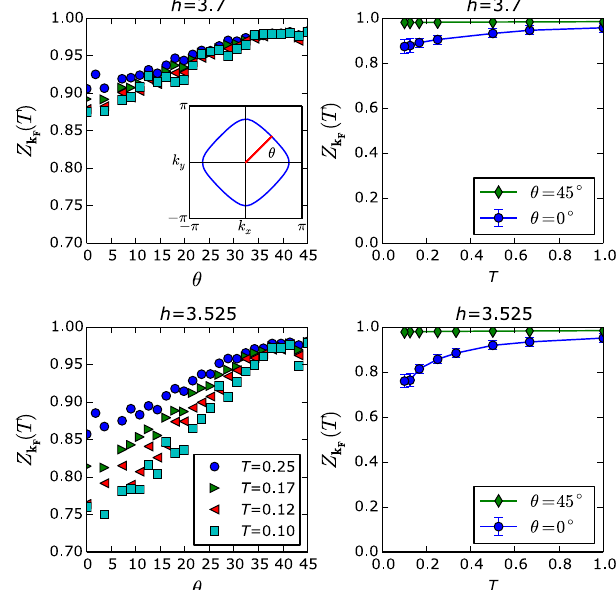
FIG. 18. Left-hand panels show Z k [defined in Eq. (15)] as a F function of angle θ along the Fermi surface, for different values ≈ 3 . 525 . Right-hand panels show the of h . The QCP is at h c temperature dependence of Z k ð T Þ for high-symmetry directions F of k . Z k approaches the conventionally defined quasiparticle F F weight as T → 0